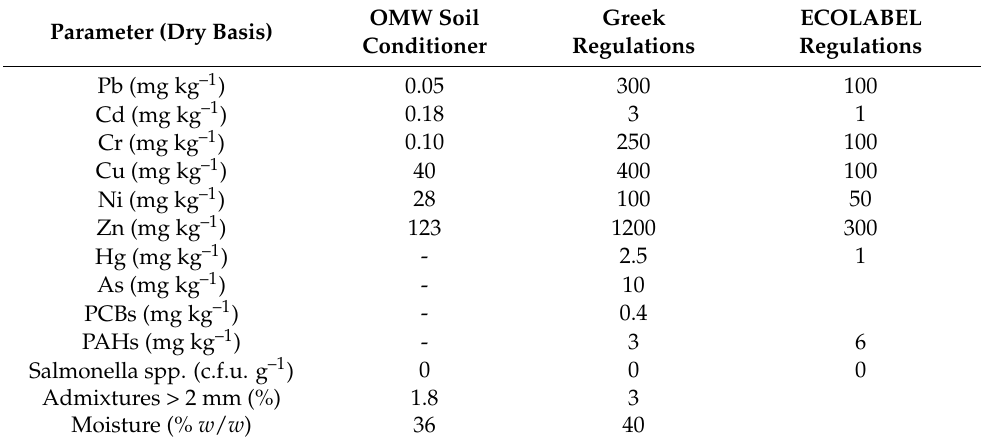
Table 3. Evaluation parameters for the bioremediated OMW compared to those of the Greek (Gov- ernmental Ministerial Decision 56366/4351, 2014) and ECOLABEL (Commission Decision (EU) 2015/2099 of 18 November 2015) regulations for soil conditioners.